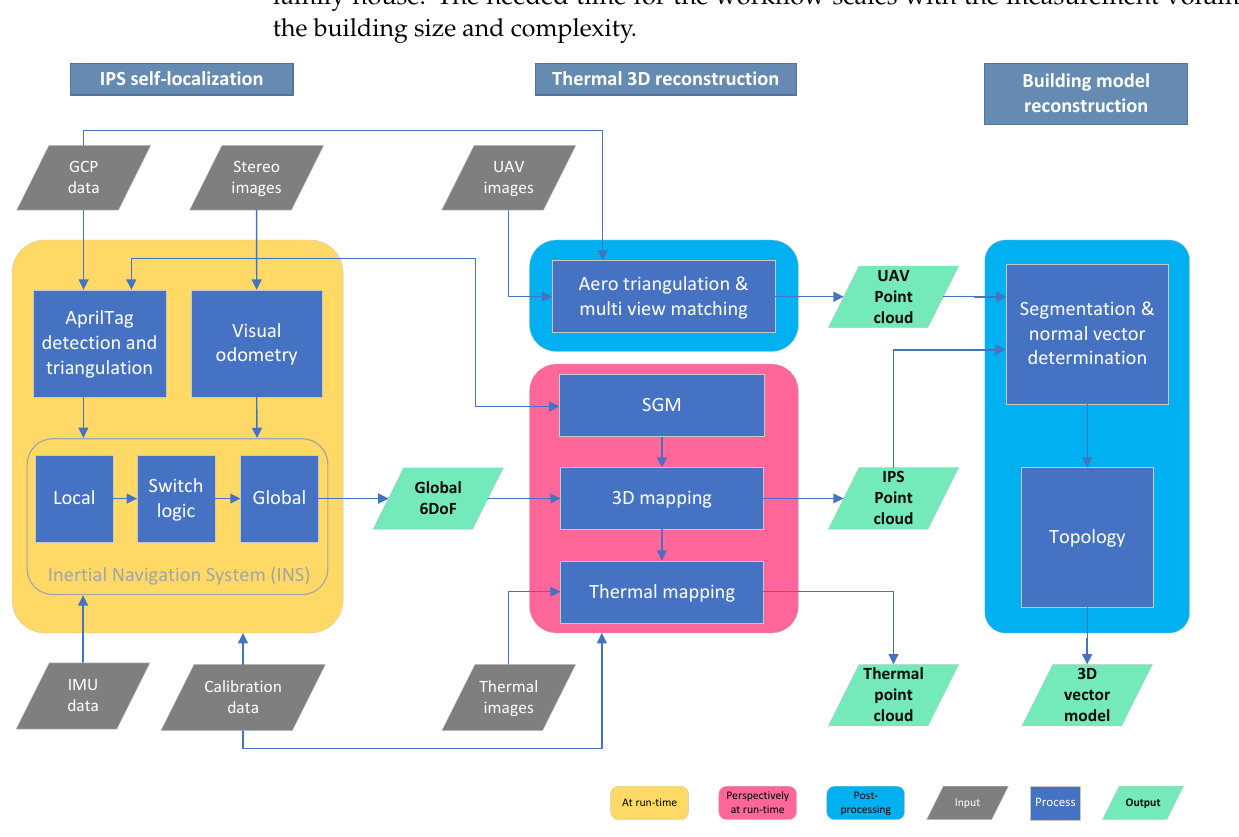
Figure 5. Workflow with our three thematic blocks, IPSself-localization , Thermal 3D reconstruction , and Building model reconstruction , structured according to processing